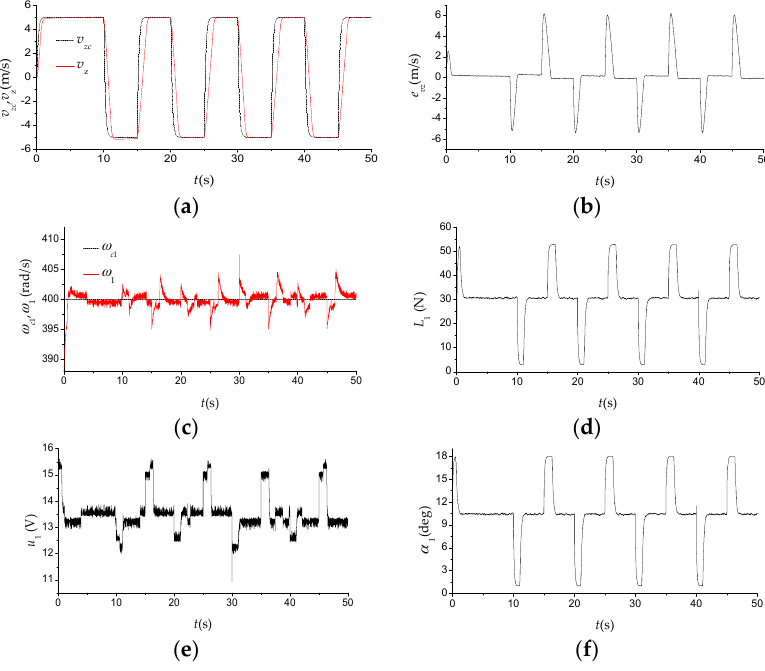
Table 3. The endurance performance versus rotational speeds. Battery Capacity